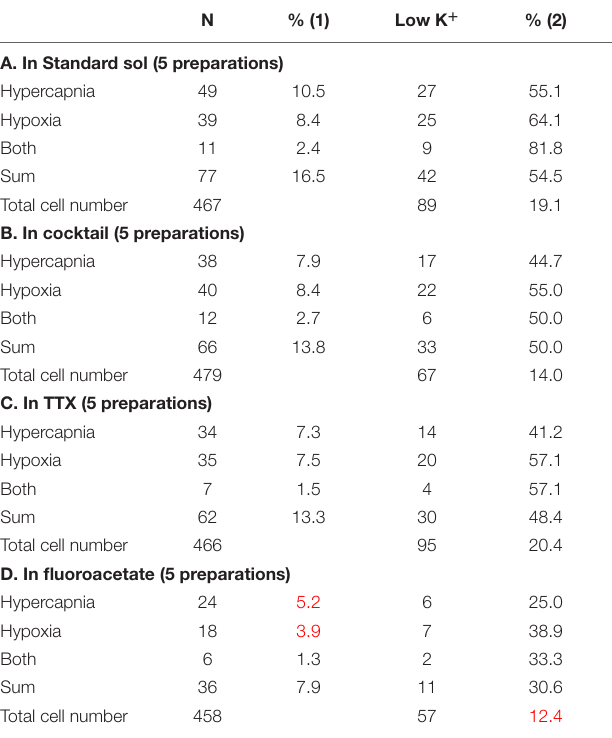
TABLE 1 | Summary of number of responding cells and total cell